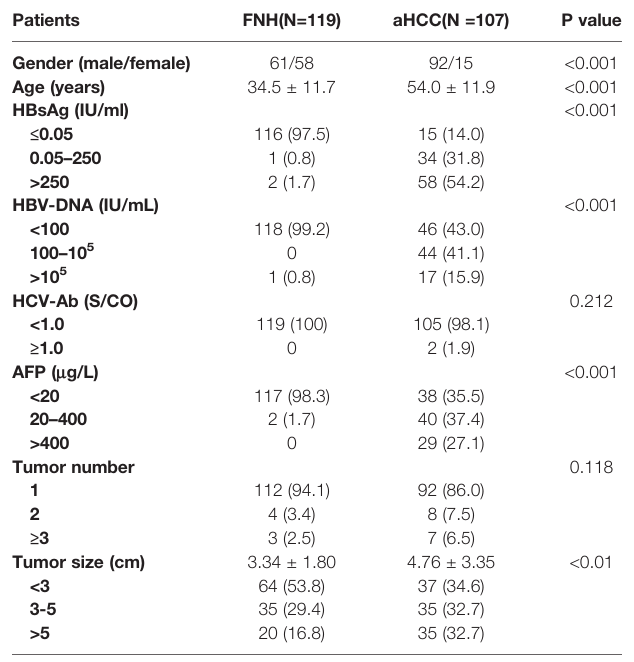
TABLE 2 | Diagnostic Performance of the Three Models in Differentiating Focal Nodular Hyperplasia and Atypical Hepatocellular Carcinoma.